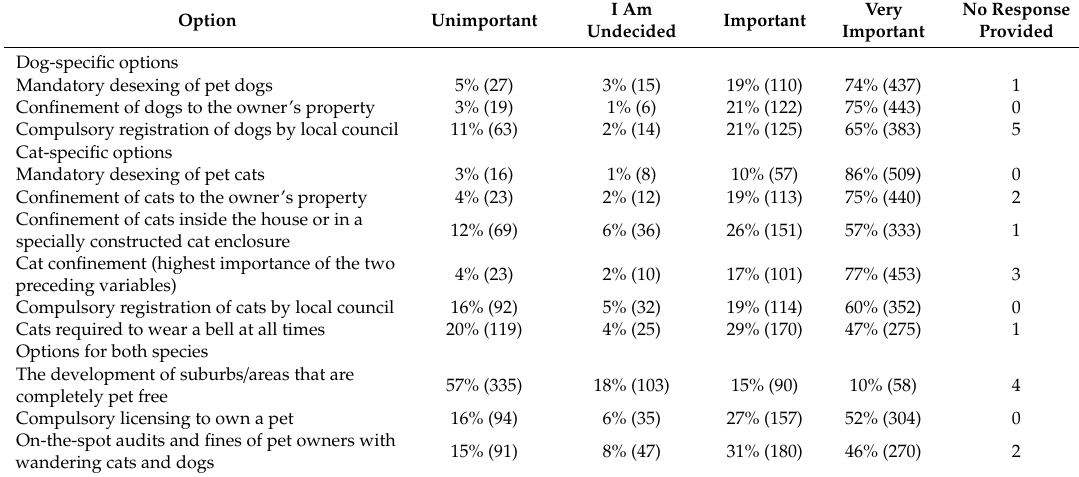
Table 7. Distributions (percentages 1 and numbers) of 590 respondents by views about the importance of various options for controlling domestic (owned) dog and cats. Option Unimportant